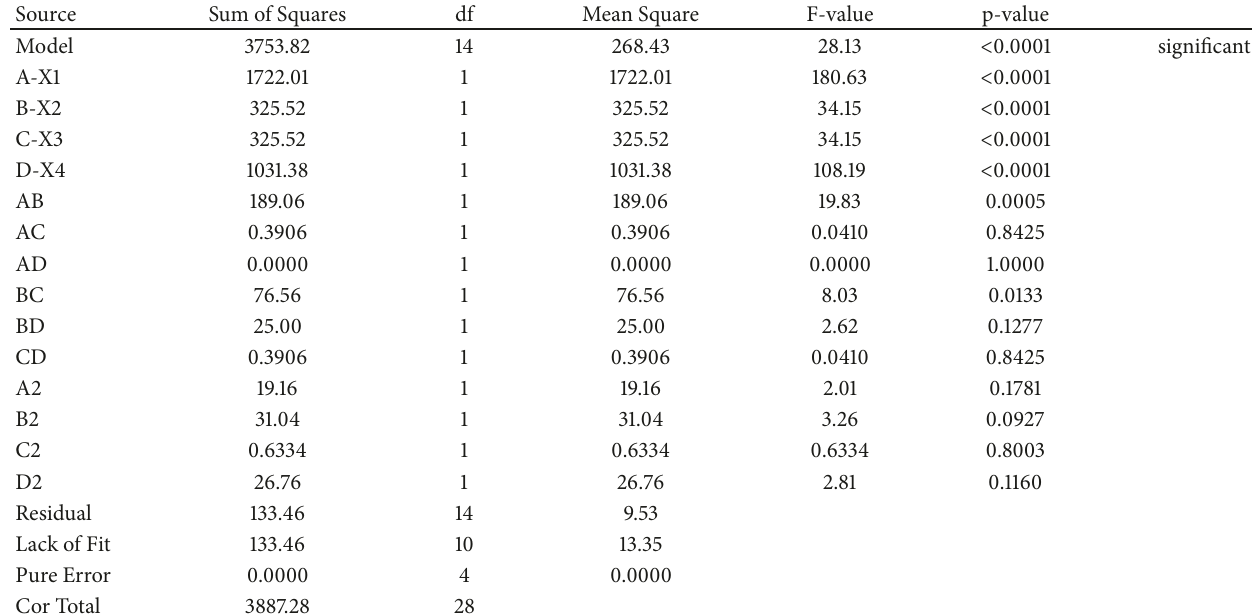
Table 5: ANOVA for the quadratic model.